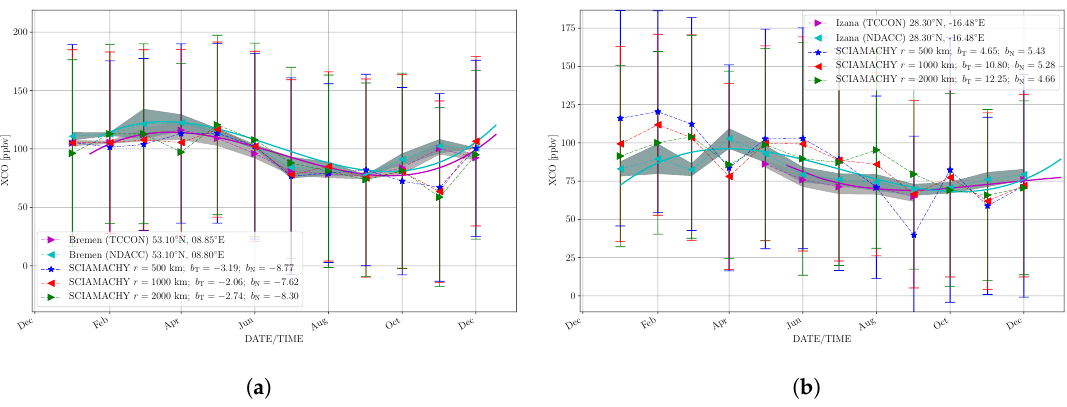
Figure 6. xCO monthly averages around the collocated NDACC and TCCON sites in 2007. ( a ) SCIAMACHY xCO values calculated for various distances from the reference site in Bremen. Measurements of the SCIAMACHY within 1000 km show the smallest bias b ; ( b ) xCO averages with respect to Izana in 2003. On this site the SCIAMACHY observations within 500 km of the reference site show the smallest bias in total for the